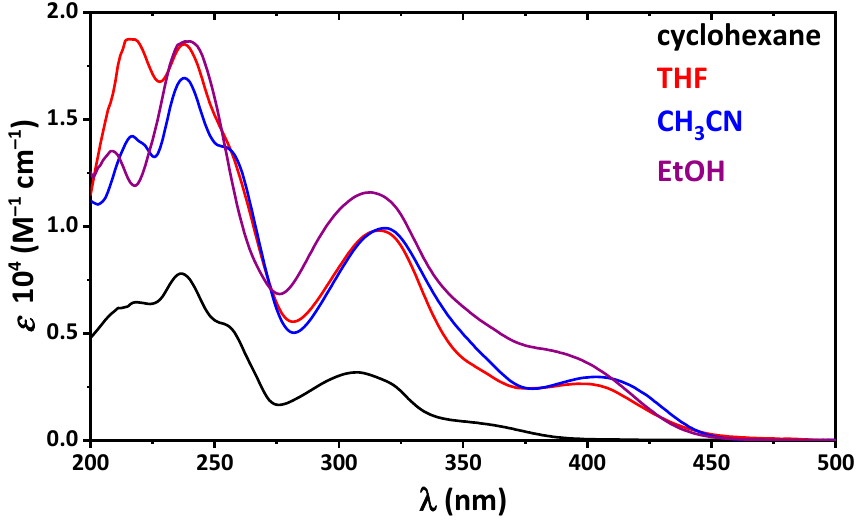
Figure 1. UV-vis spectra of 4 in the applied solvents.